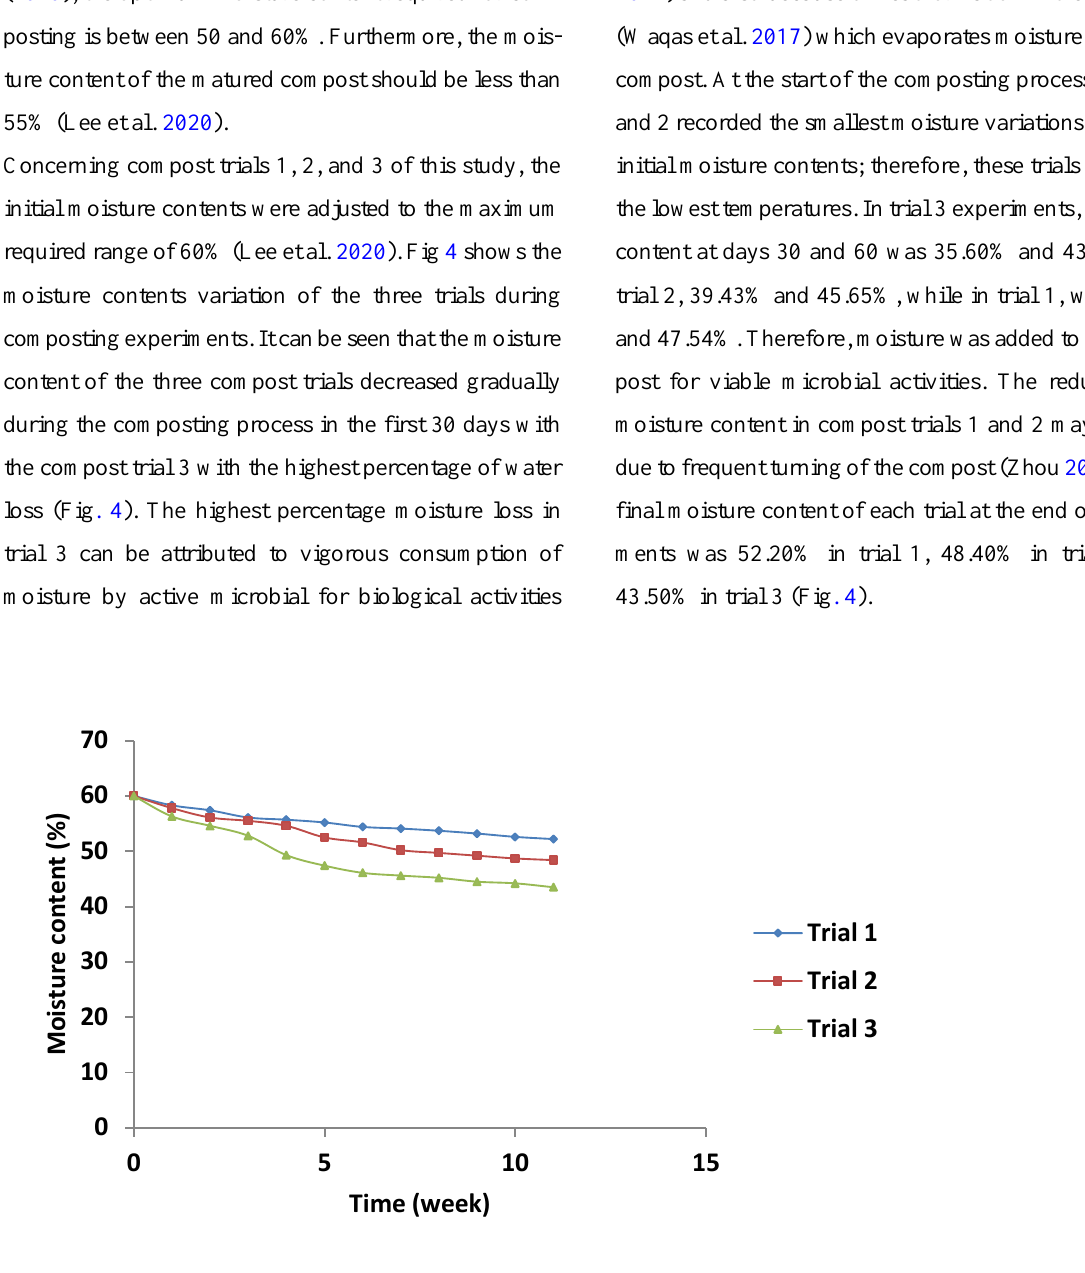
Fig. 4 Variation of moisture content of the three trials during composting Evaluation of pH and electrical conductivity (EC) The pH range is one of the most important factors in the composting experiment. Waqas et al. (2017)